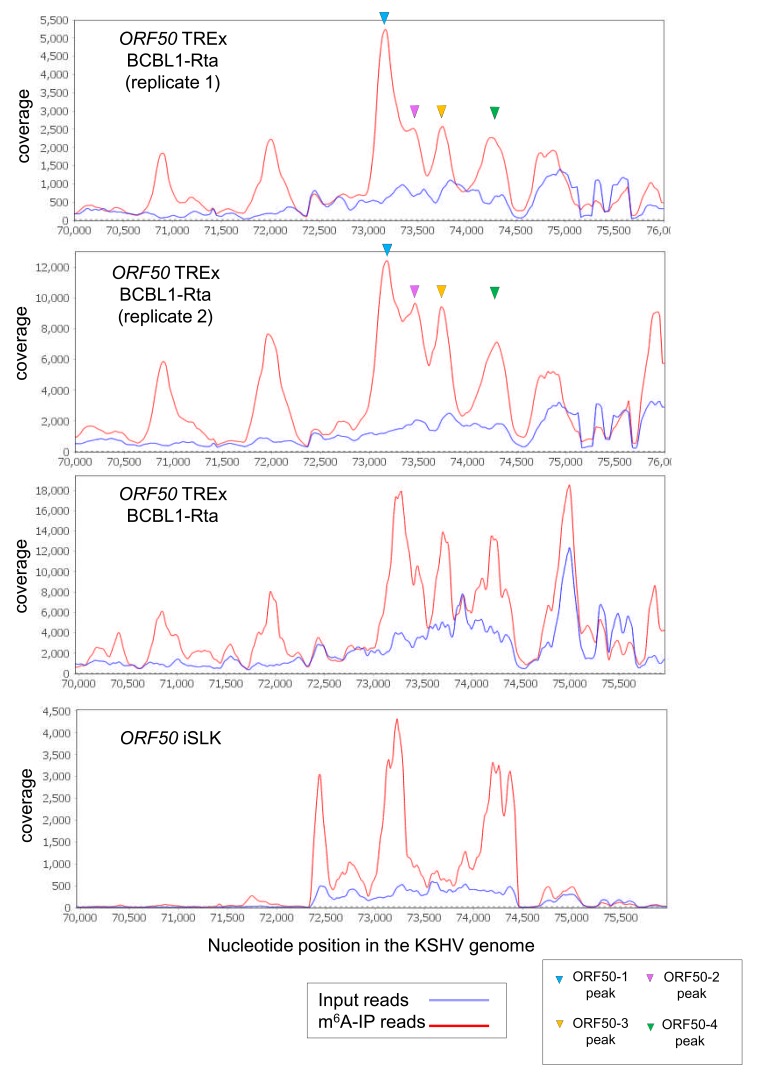
Viral ORF50 RNA is consistently detected as m6A-modified in different m6A-seq datasets.Top two deep-sequencing coverage tracks of ORF50 RNA are shown for our two lytic biological replicates at 20 hr reactivation in TREx BCBL1-Rta cells. The four m6A peak positions which we further focussed on this study are highlighted. Below is the coverage for ORF50 RNA at 48 hr reactivation in TREx BCBL1-Rta cells from Tan et al. (2018). Bottom panel shows the coverage of ORF50 RNA in iSLK cells (24 hr post-reactivation) from the Tan et al. study (Hesser et al., 2018).